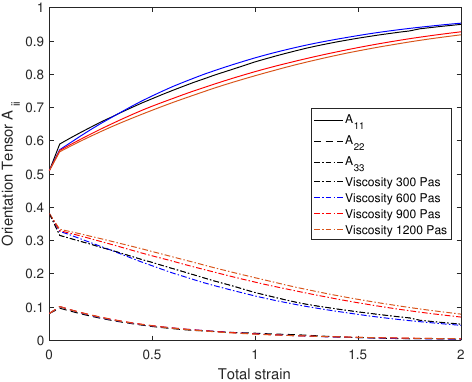
Figure 10. Fiber orientation evolution under elongational flow with different matrix